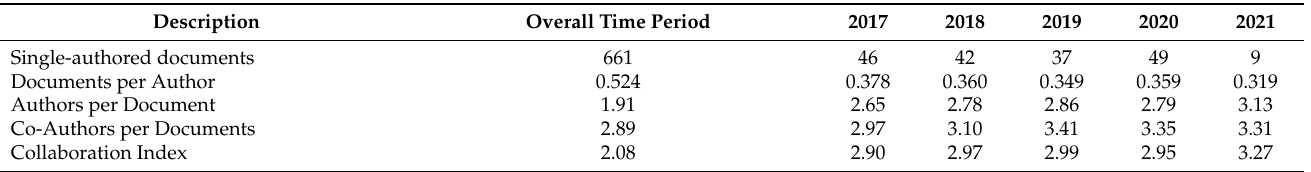
Table 4. Authors’ collaboration, overall period, and per year. Note: The Collaboration Index (CI) is calculated as total authors of multi-authored articles/total multi-authored